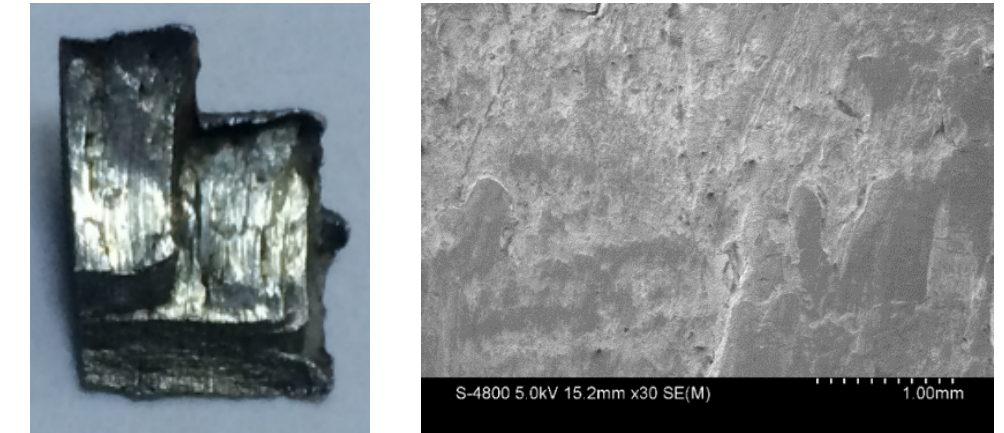
Figure 9. Typical fracture surface of fragment from Specimen 1# (left) and its morphology captured by SEM (right).